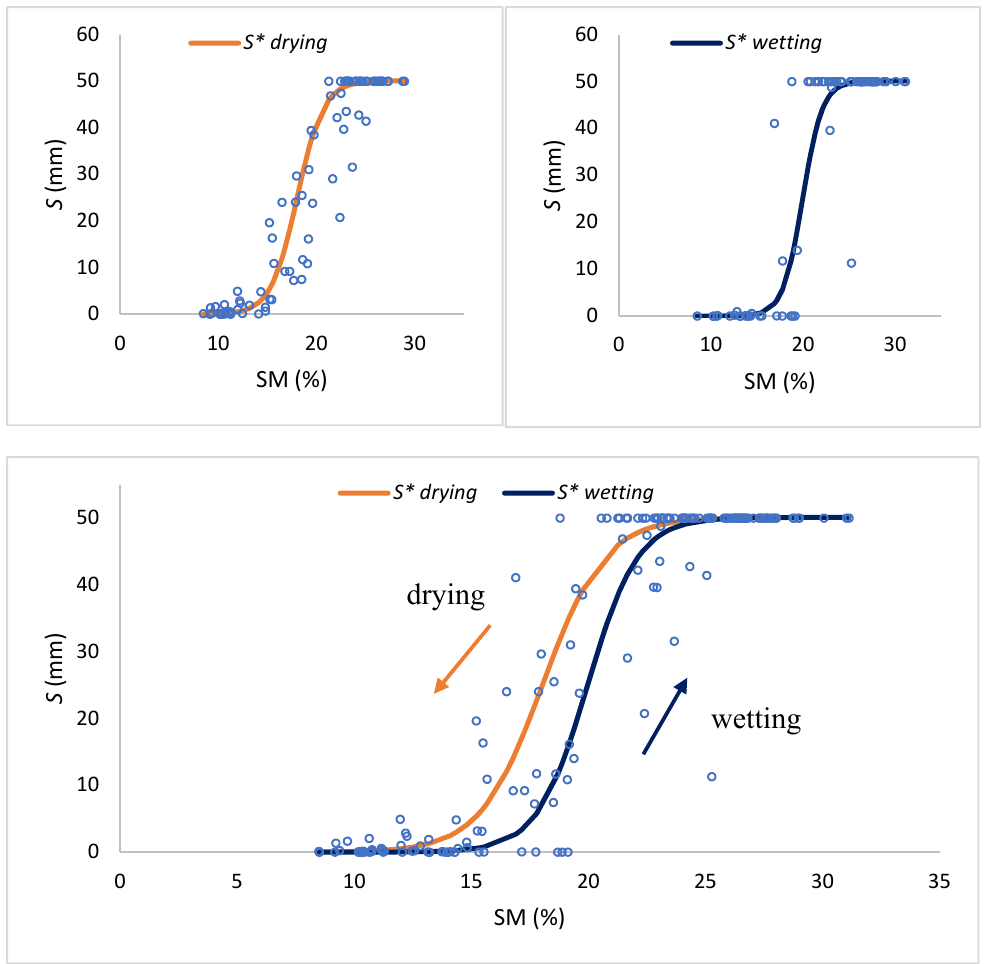
Figure 10. Segregated model (III) fitted to data subsets corresponding to the recharge (wetting) or depletion (drying) periods, with Smax 50 mm ( S * stands for S estimates by the regression model).